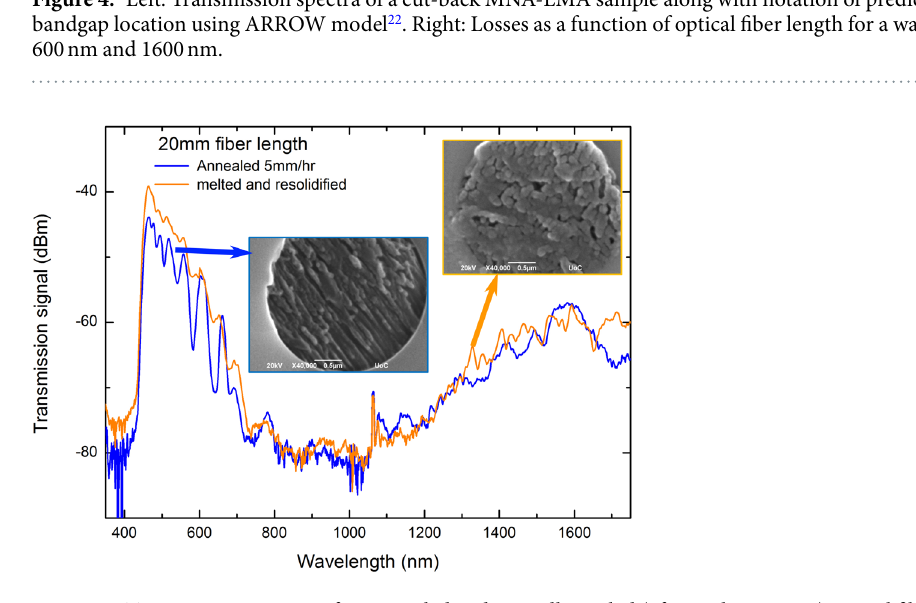
Figure 5. Transmission spectra of an annealed and a rapidly cooled (after melting MNA) optical fiber along with their respective capillary SEM